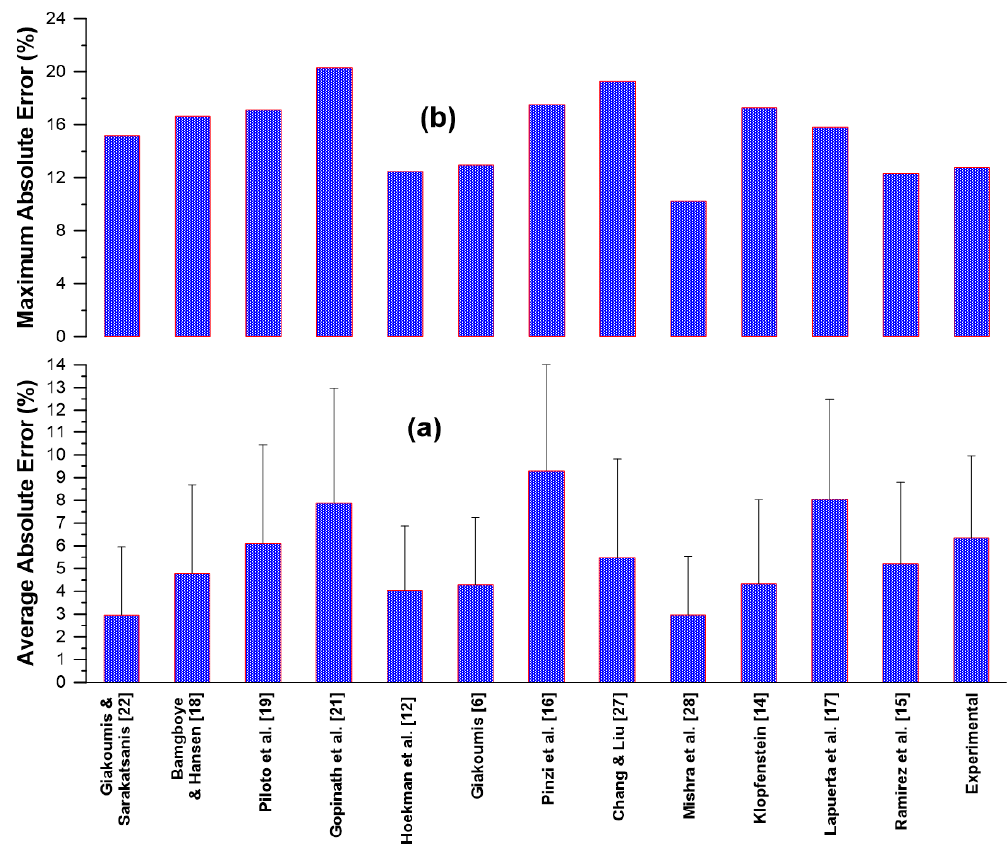
Figure 5. Comparative illustration of average ( a ) and maximum ( b ) absolute errors from all models’ predictions based on the results of Table 5.